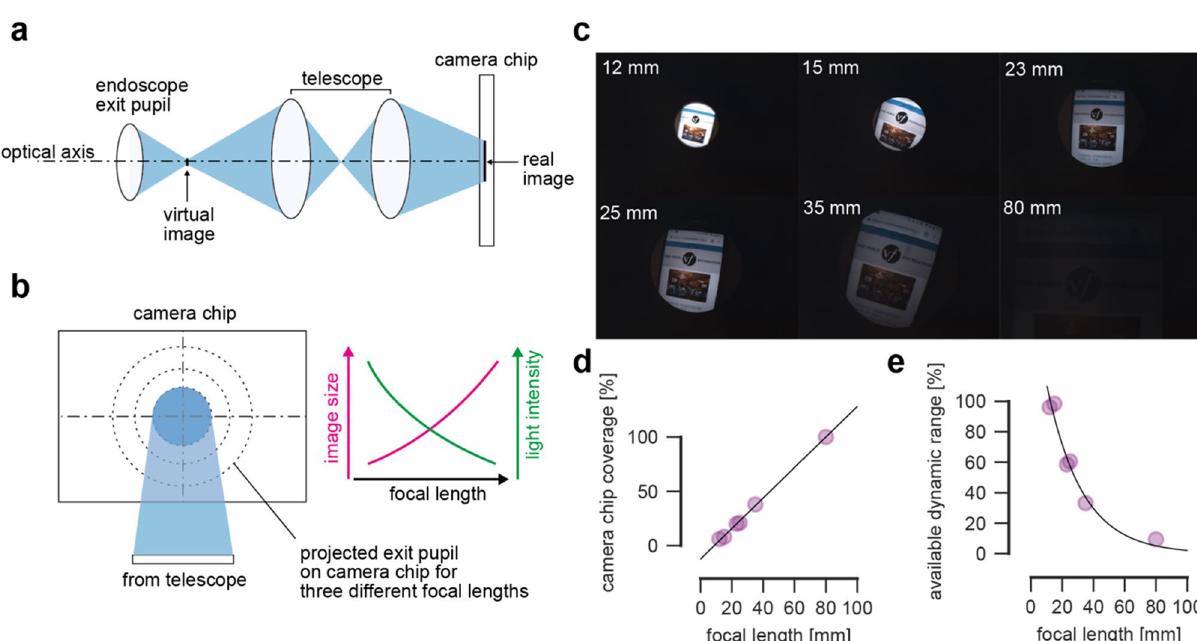
Figure 5. Image formation process. ( a ) Optical setup including the endoscope exit pupil, the lens simplified as telescope, and the camera chip. The real image is formed on the camera chip. ( b ) Image size on camera chip depending on the focal length. Focal length and image size vary proportionally; focal length and light intensity are inversely correlated. ( c ) Example images from the same scenery with lenses with varying focal lengths. ( d ) Chip coverage in percent vs. focal length. Black line indicates one-exponential fit. ( e ) Available dynamic range vs. focal length. Black line indicates one-exponential